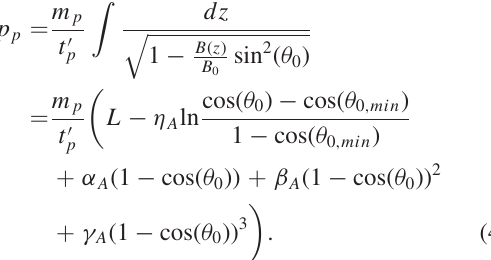
Figure 3. Left : simulated 1 / t (cid:7) 2 take into account the detector response function through analysis ‘Method A’ as described in the text. Right : simulated detector response function for without electric field ( p 2